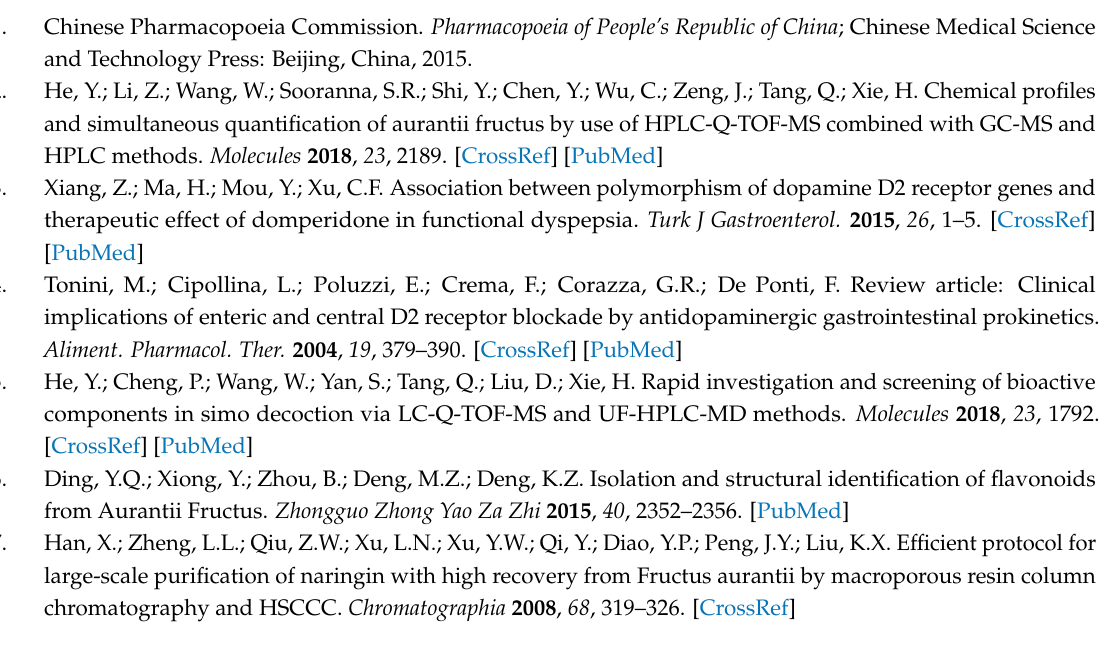
Supplementary Materials: Table S1. Docking score of antagonistic ability on D 2 dopamine receptor, potential prediction and feasibility of preparative separation of chemical compounds from Aurantii fructus; Figure S1. The detailed data of isolated compounds with high purity identified by ESI-Q-TOF-MS, 1H-NMR and